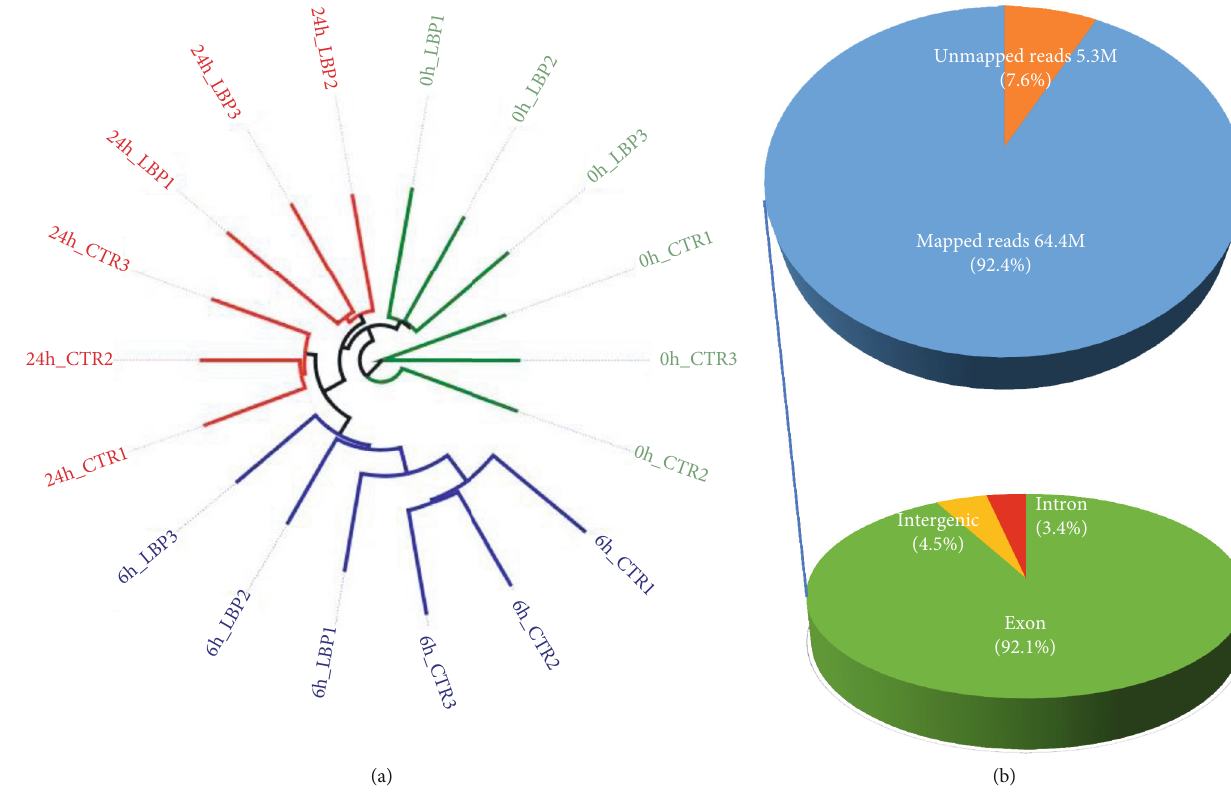
Figure 1: Summary of RNA-seq data of normal and LBP-de fi cient rats. (a) Neighbor-joining tree of normal and LBP-de fi cient samples treated with LPS for the times indicated (0 h, 6 h, and 24 h). Each condition has 3 replicates. Logarithm transformed counts from the RNA-seq dataset were computed for sample correlation by Pearson ’ s correlation. CTR: normal rat; LBP: LBP-de fi cient rat. (b) A pie chart of average mapping statistics involving RNA-seq